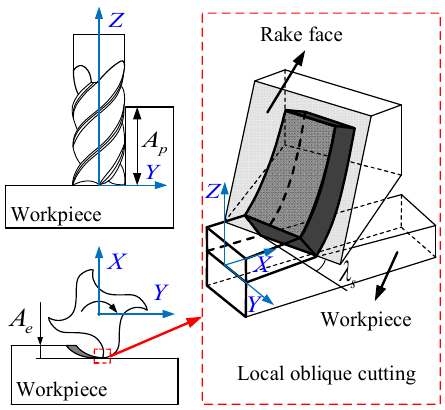
Figure 1. The conversion diagram of oblique cutting for end mills.